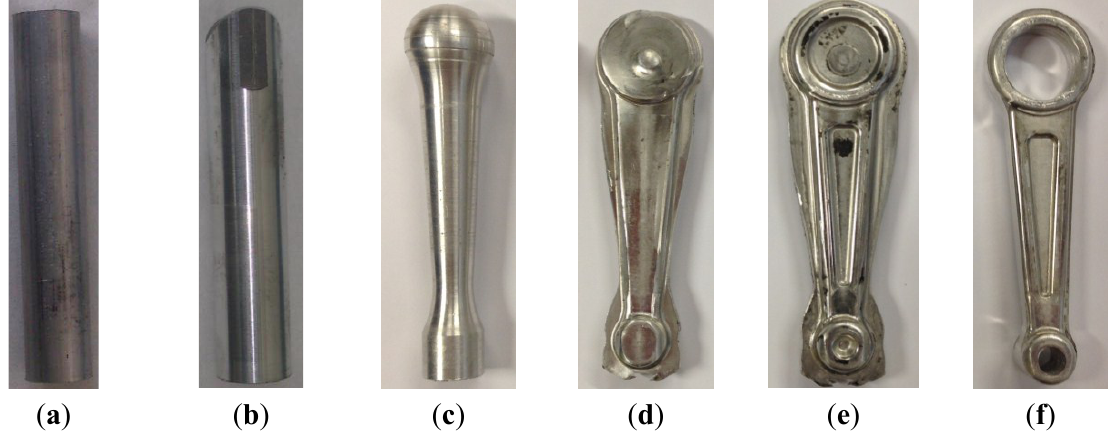
Figure 1. Stages followed in the manufacturing of the connecting rods: ( a ) N0; ( b ) N2; ( c ) Preform; ( d ) first stroke; ( e ) second stroke; ( f ) final shape.